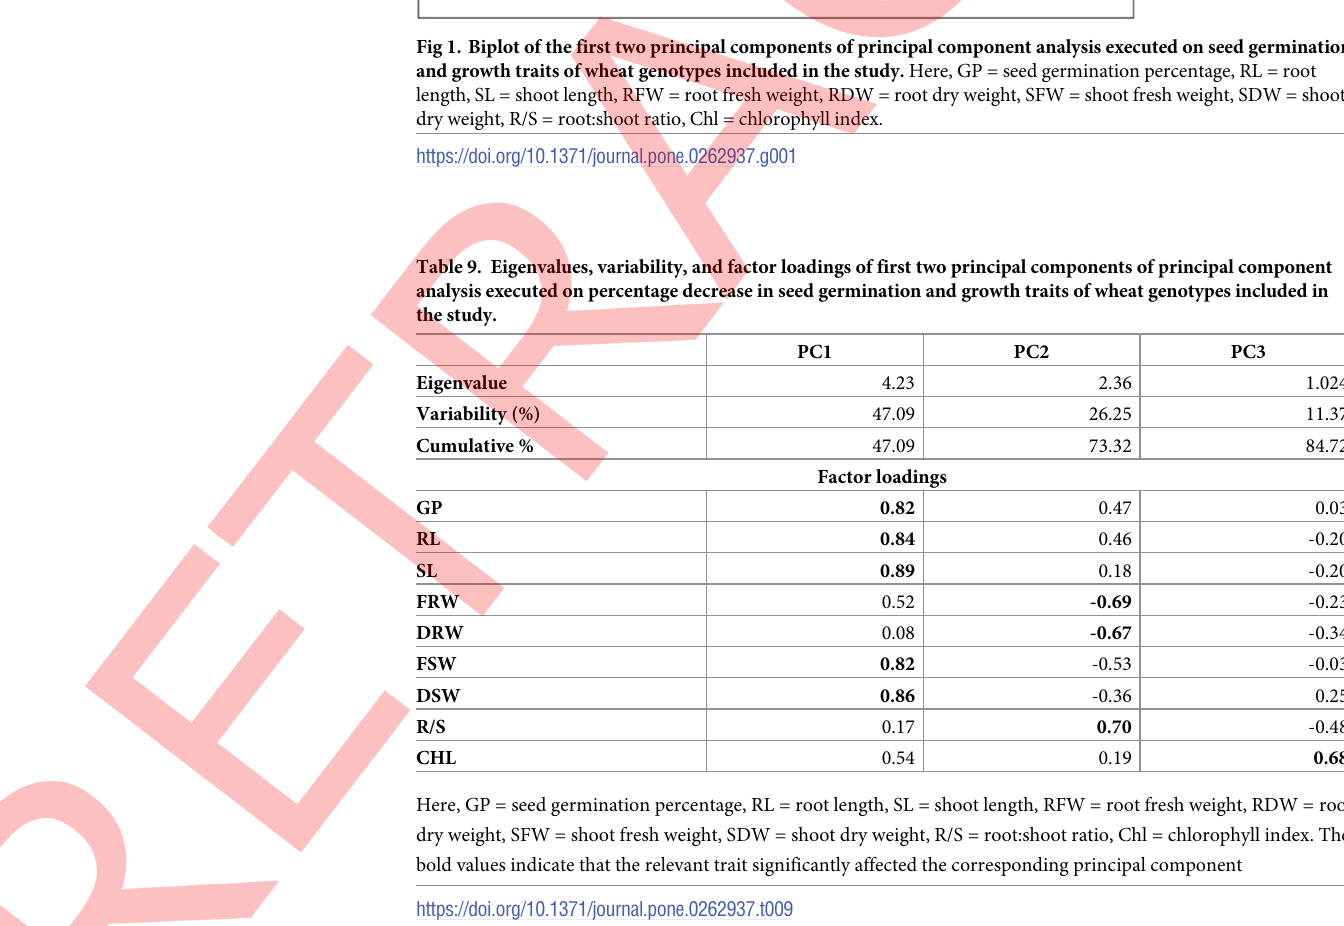
Table 9. Eigenvalues, variability, and factor loadings of first two principal components of principal component analysis executed on percentage decrease in seed germination and growth traits of wheat genotypes included in the study.